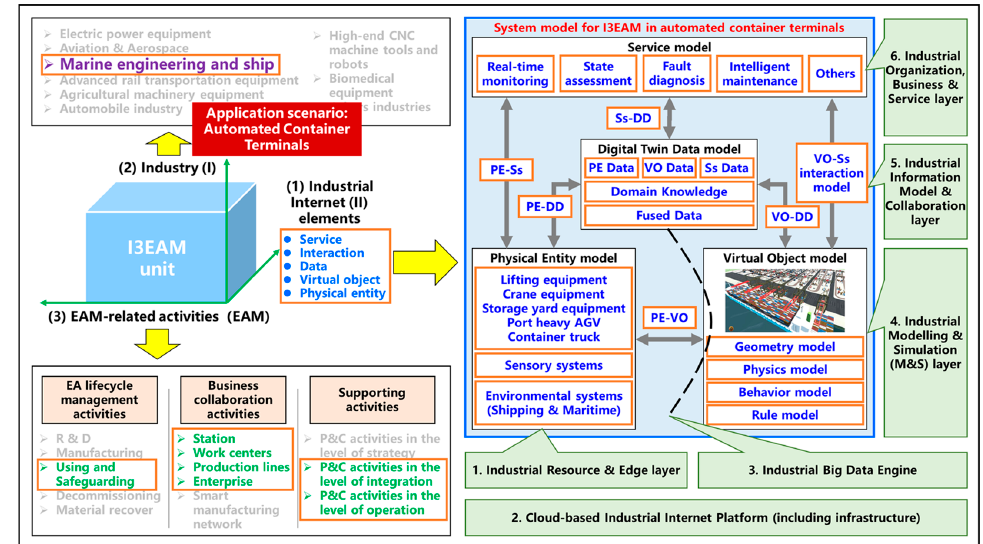
Figure 10. Reference model of I3EAM schemes in automated container